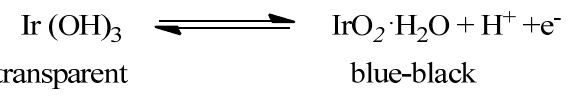
Scheme 1. Redox reaction at the basis of IrO2 EC properties.